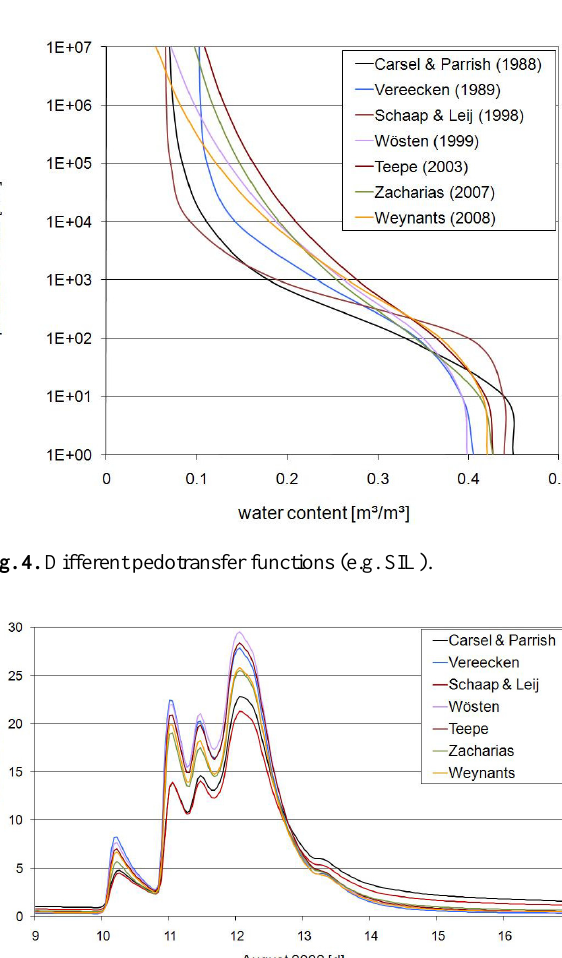
5 Figure 5: Windach Catchment (northern part, AE = 68 km²), HQ10, Application of seven 6 Fig. 5. Windach catchment (northern part, A E =68km 2 ), HQ 10 , different Pedotransfer Functions 7 application of seven different pedotransfer 8